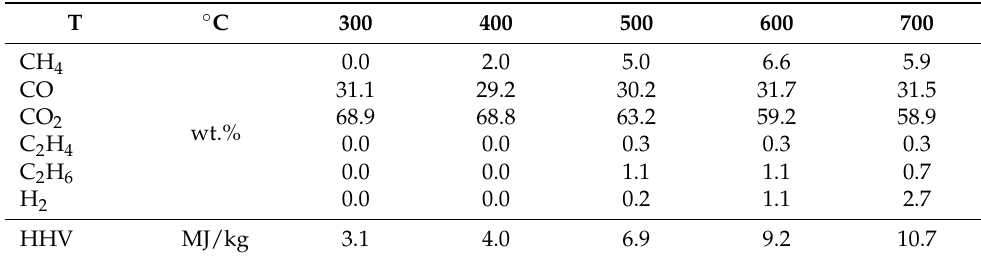
Table 3. Composition and HHV value of the gaseous product from pyrolysis of lignin rich residue (LRR) at different final temperatures.